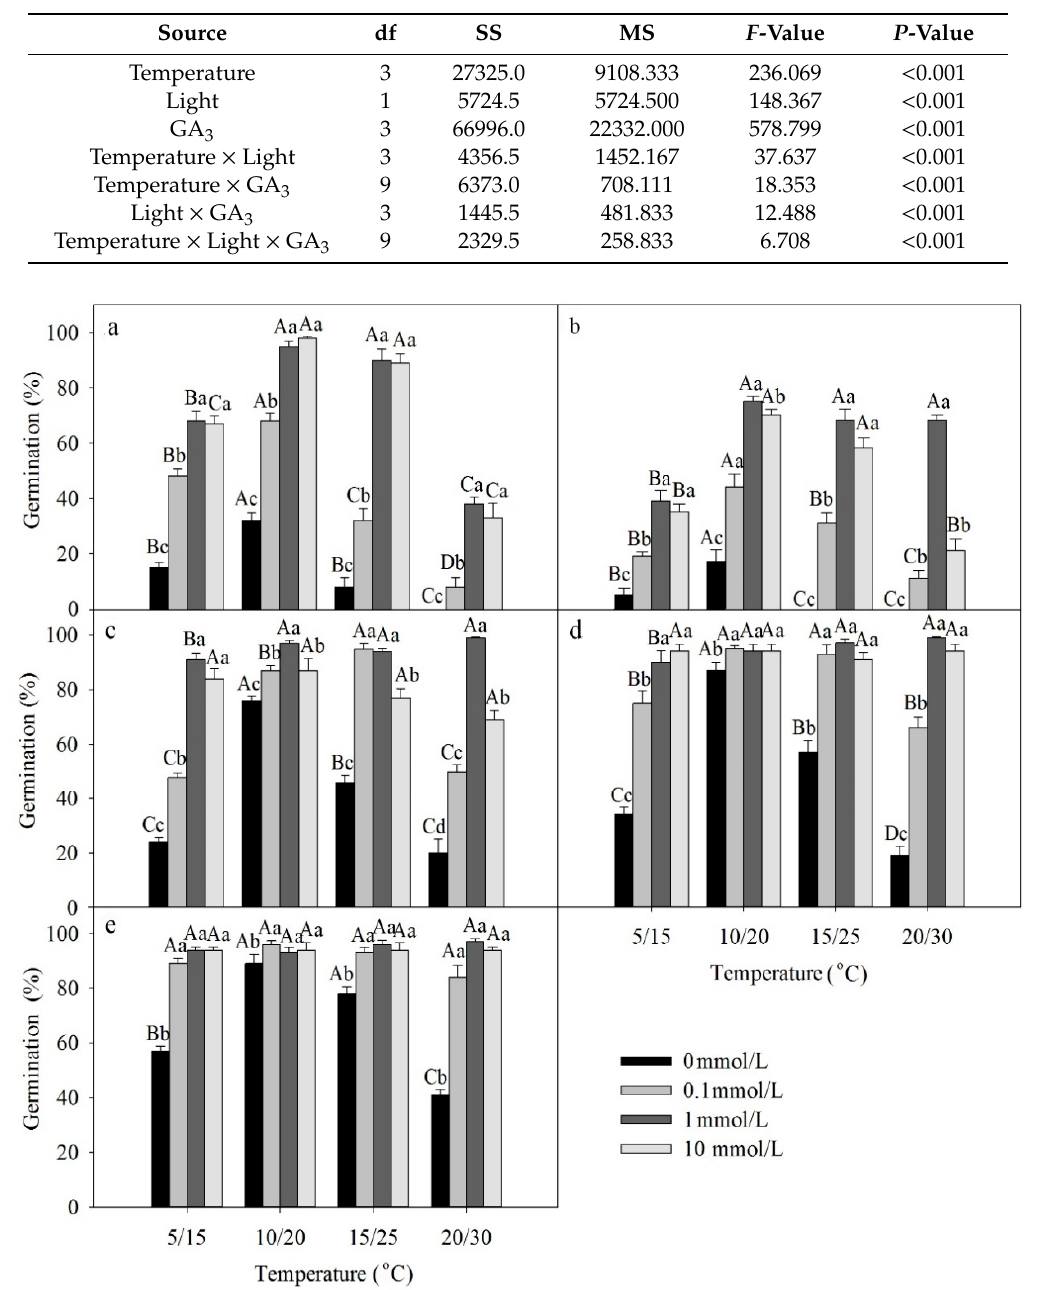
Table 2. Three-way ANOVA results testing the e ff ects of temperature, light condition, GA 3 and their interactions on germination of freshly matured Lepidium apetalum seeds. df, degree of freedom; MS, mean square; SS, sum of squares.